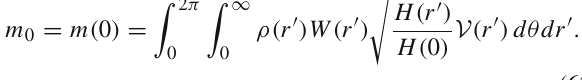
Fig. 5 The energy density (49) of the scalar field in the D → 4 limit. a The energy density for different values of the parameter β and α = 1. b The energy density for different values of the GB coupling constant and β = 1 / 2. For both cases, we set the parameter k to